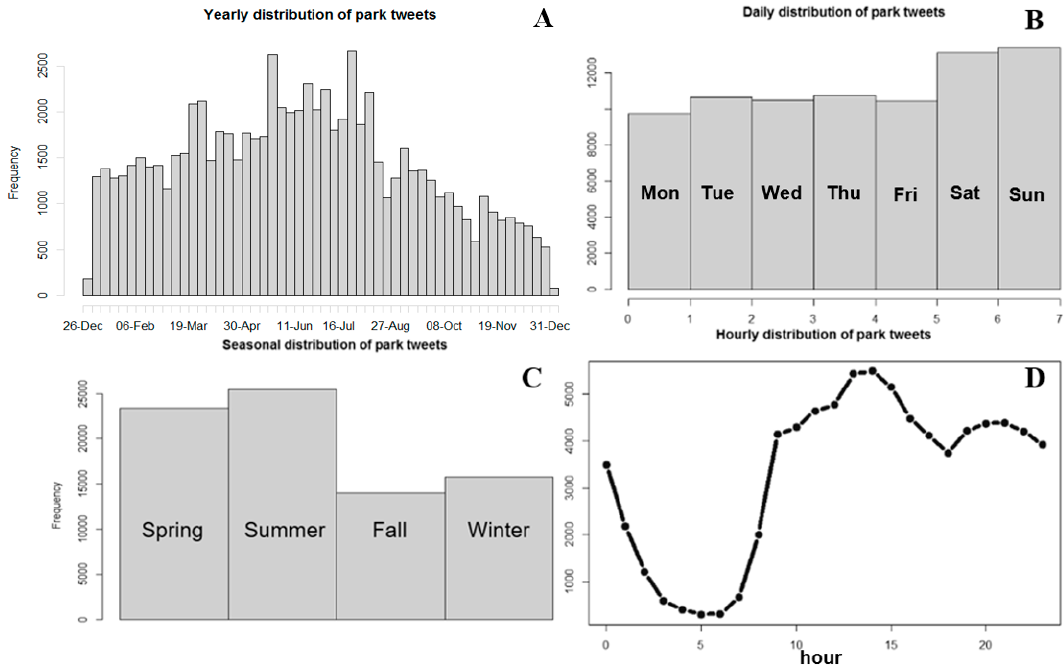
Figure 13. Temporal distribution of tweet frequency (( A ) yearly; ( B ) weekly; ( C ) seasonal; and ( D ) hourly).